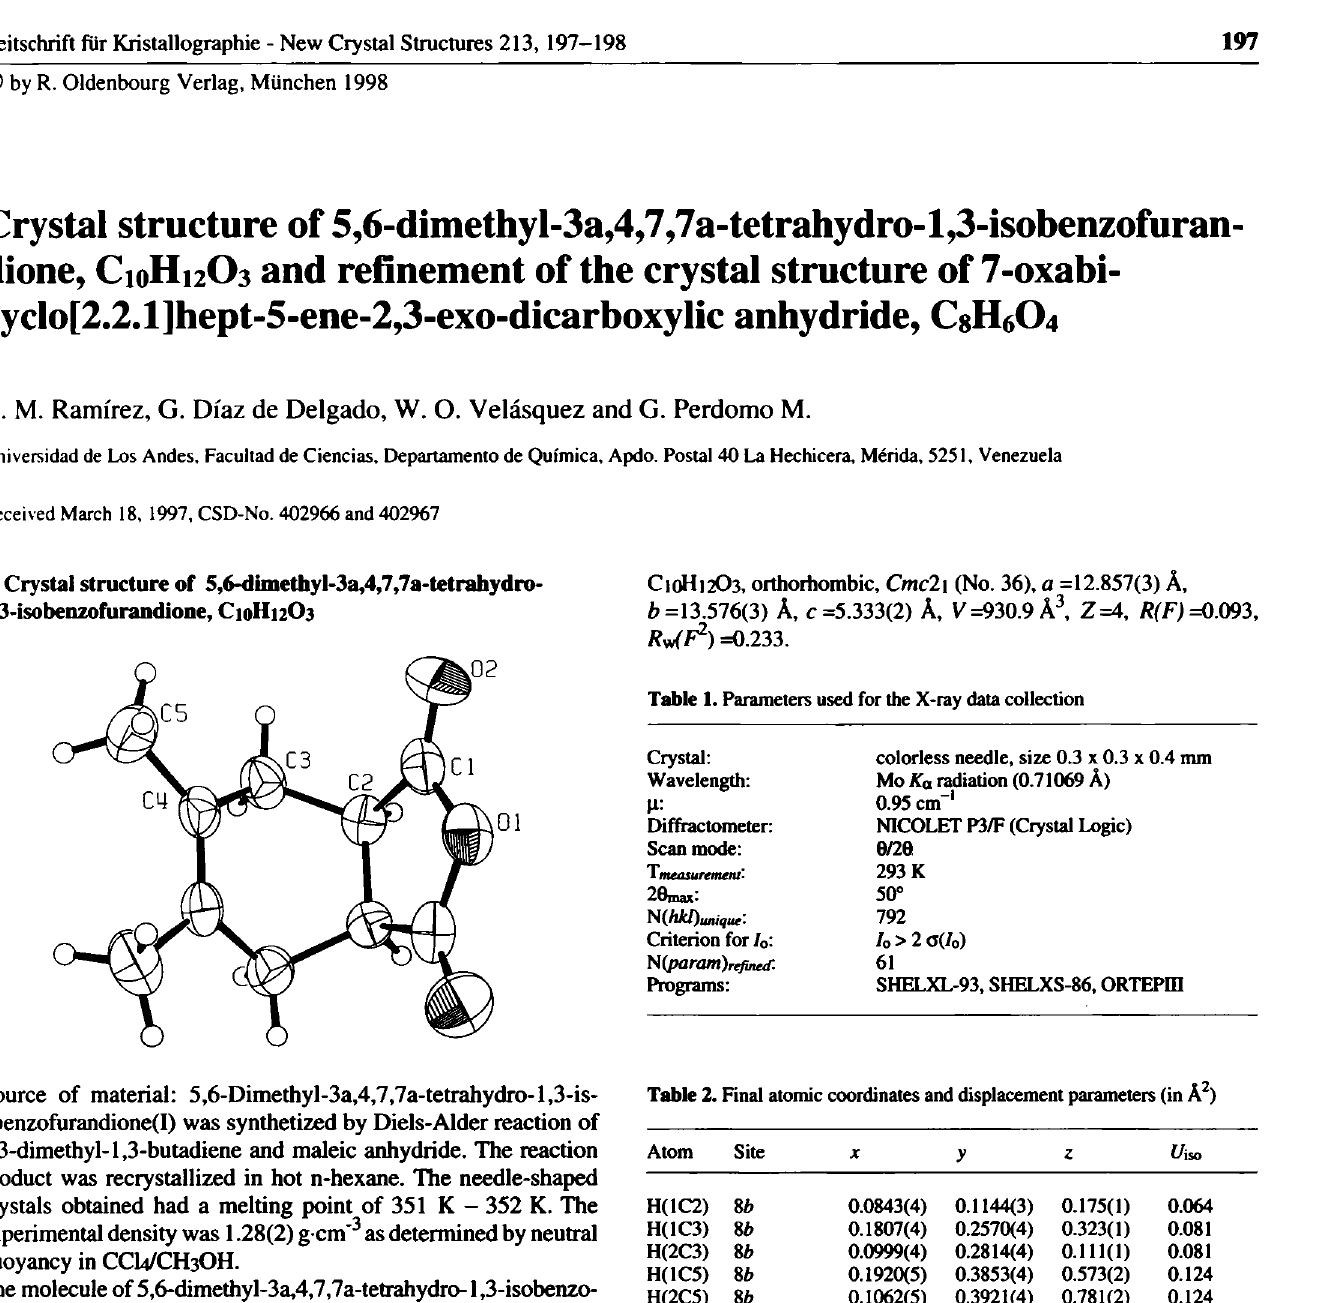
Table 3. Final atomic coordinates and displacement parameters (in Â^)